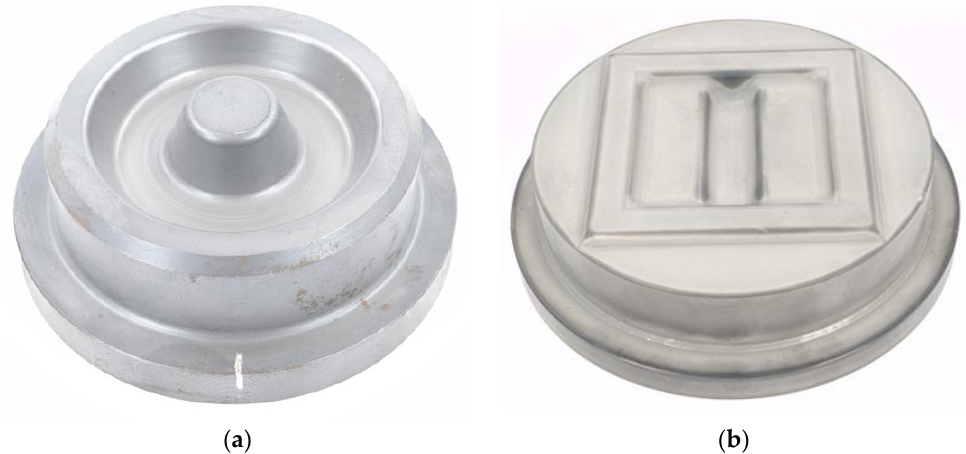
Figure 6. Selected forging die geometries for the laboratory validation processes: ( a ) Type 1 for further validation of the H11 base material data set, ( b ) Type 2 for the validation of the material data of the nitriding profile.